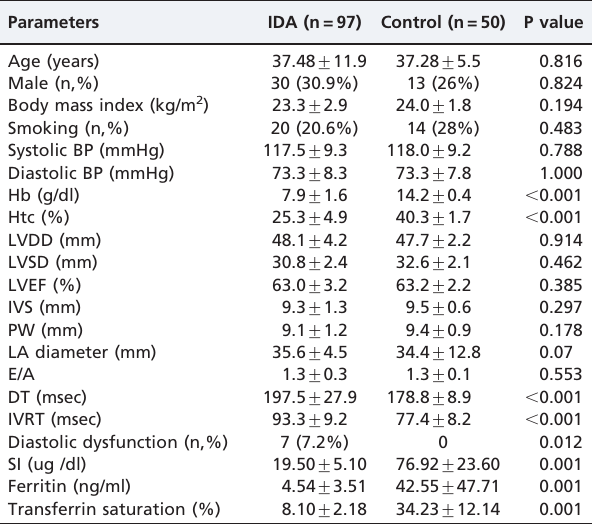
Table 1 - Comparison of clinical and echocardiographic variables for patients with iron deficiency anemia versus healthy subjects.